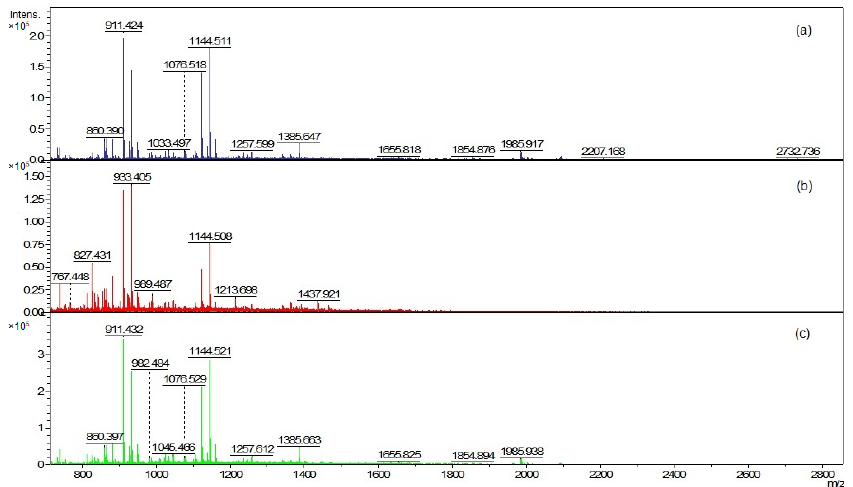
Figure 6. Positive ion MALDI-TOF MS spectra of EVs lipids ( a ) C. acnes DSM 1897 type IA1, ( b ) C. acnes DSM 16379 type IB, and ( c ) C. acnes PCM 2334 type II.